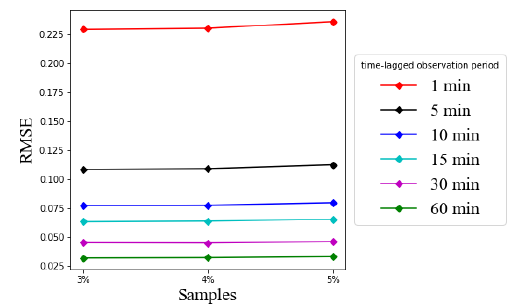
Figure 18. RMSE of sample sizes 3% to 5% with varied time-lagged observation